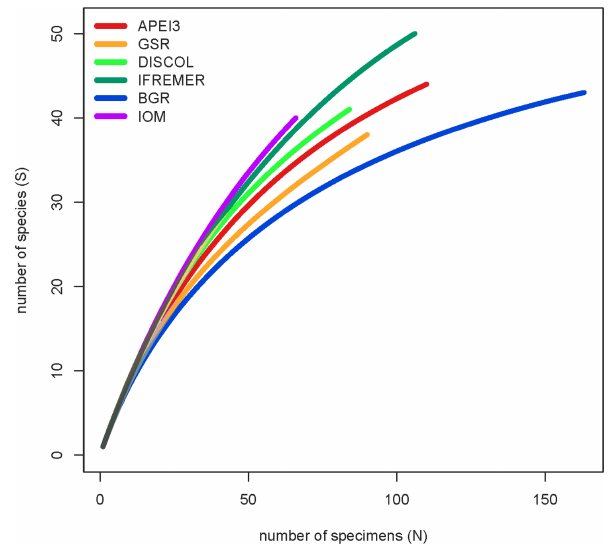
Figure 7. Rarefaction analysis by isopod family considering all ar- eas together.